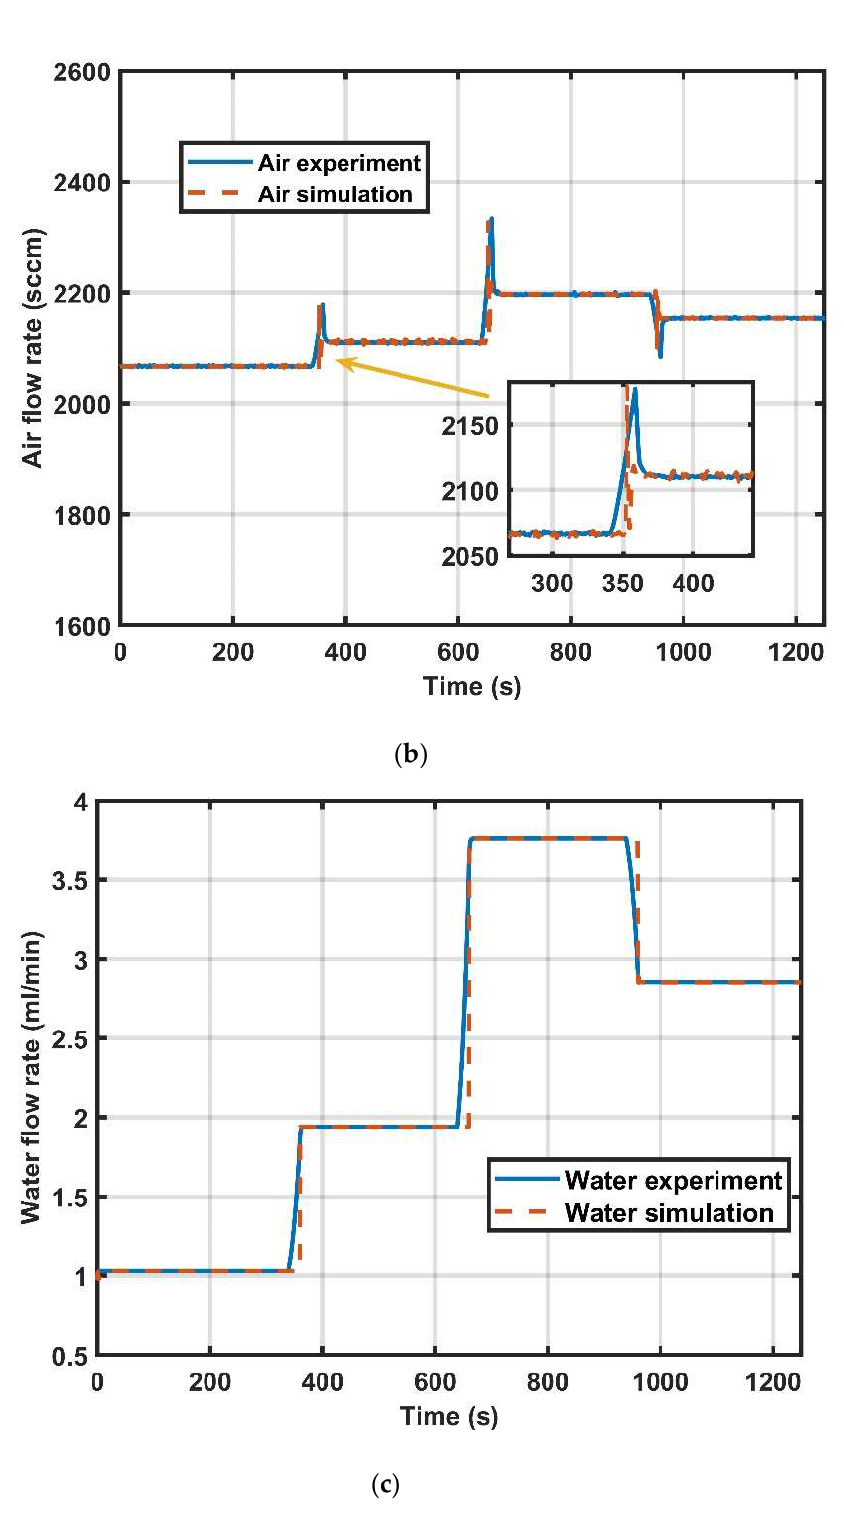
Figure 7. Schematic diagram of the feedstocks supply rate profile (( a ) DME; ( b ) High-purity air; ( c ) Water).